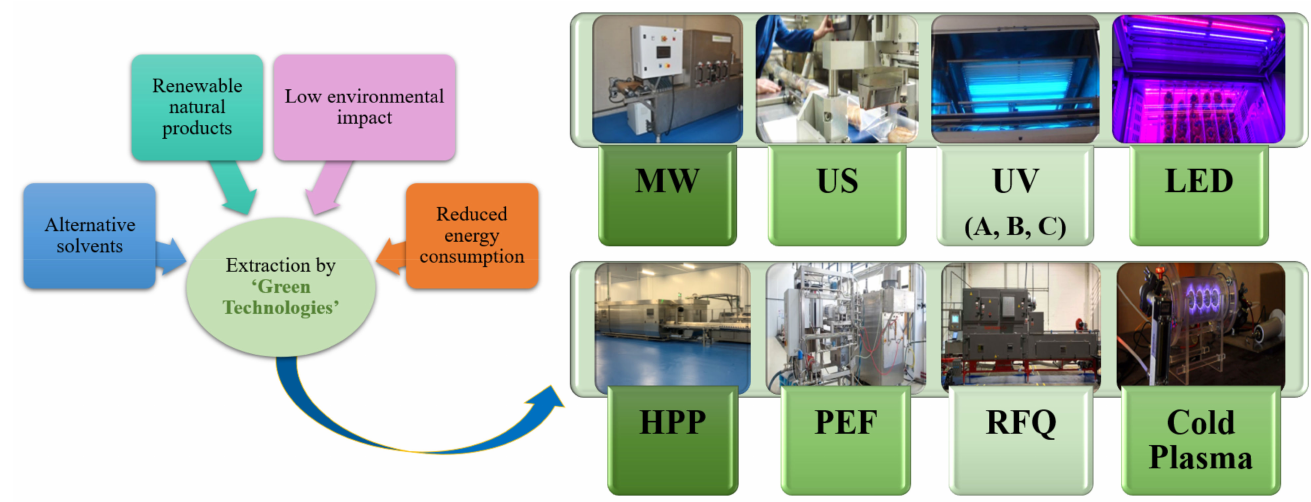
Figure 2. Green technologies to improve the healthiness of fruit and vegetable beverages. MW: microwave; US: ultrasounds; UV: ultraviolet; LED: Light Emitting Diode; HPP: High-Pressure Processing; PEF: Pulsed Electric Field; RFQ: